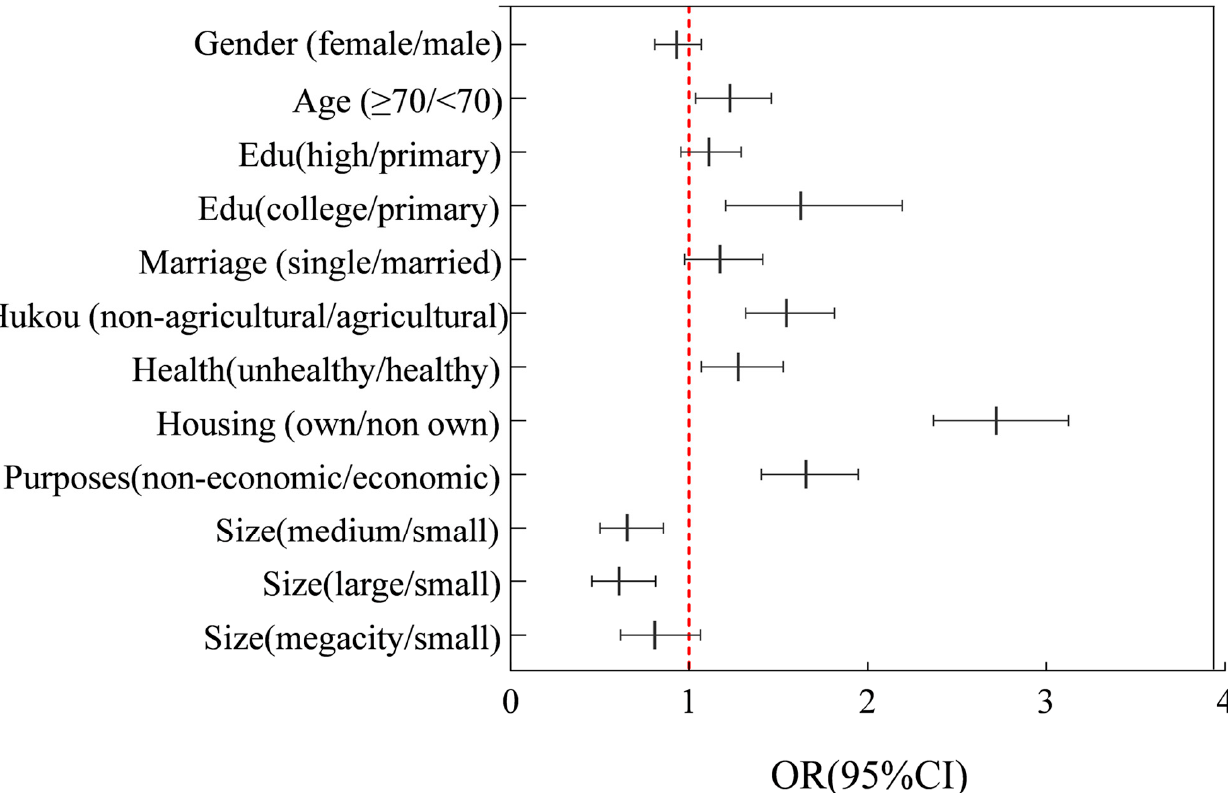
Figure 4. Odds ratio and 95% confidence interval of categorical variables from Model 1.